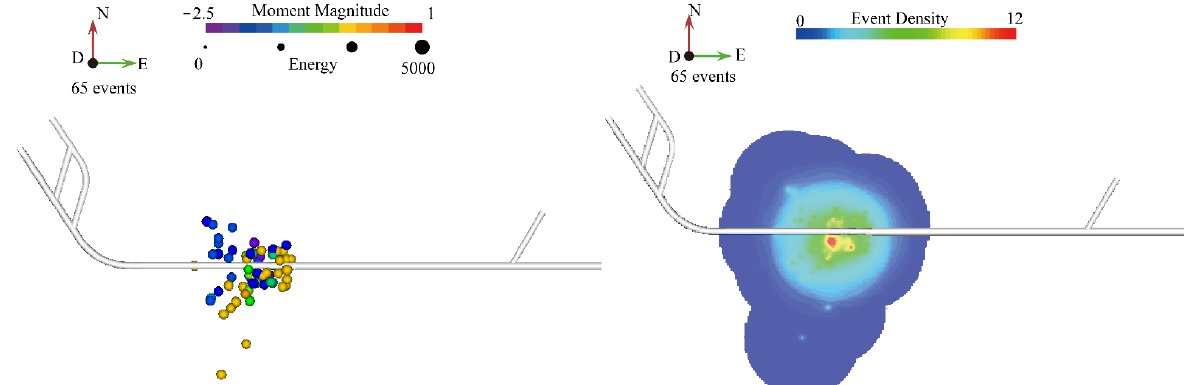
Figure 11. Distribution of MS events controlled by adverse geological structures.